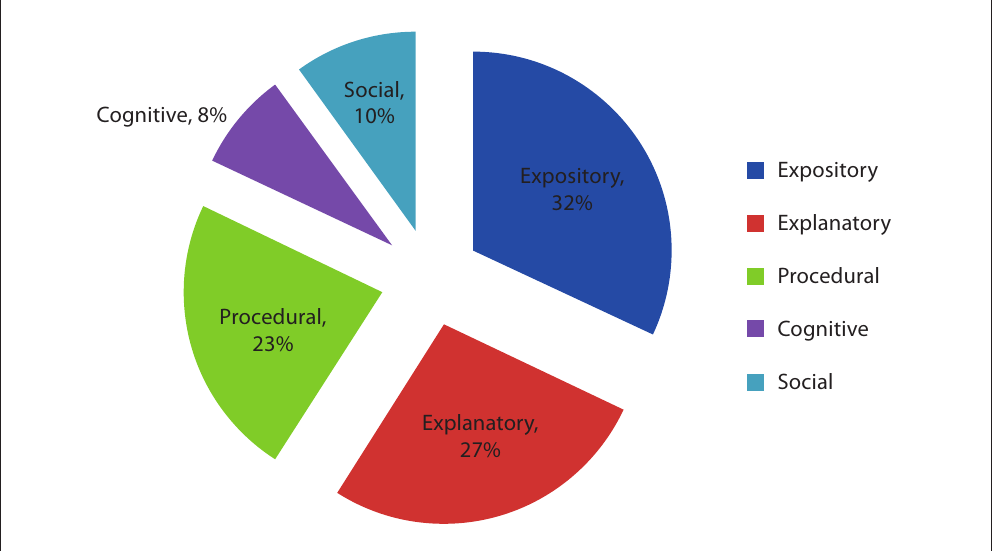
Figure 5 Dimensions of interactions in the online discussion